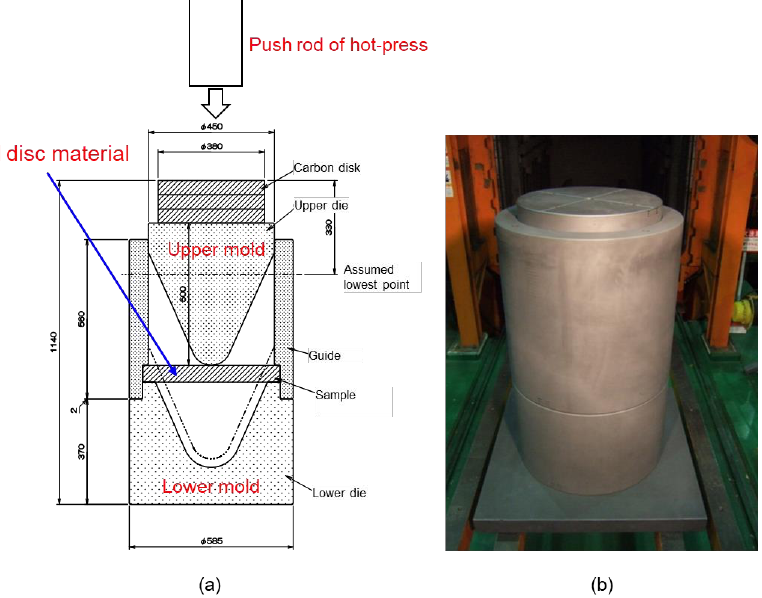
Figure 9. Forming test procedure and jig with hot-press. ( a ) Cross-sectional view and ( b ) appearance prior to forming.